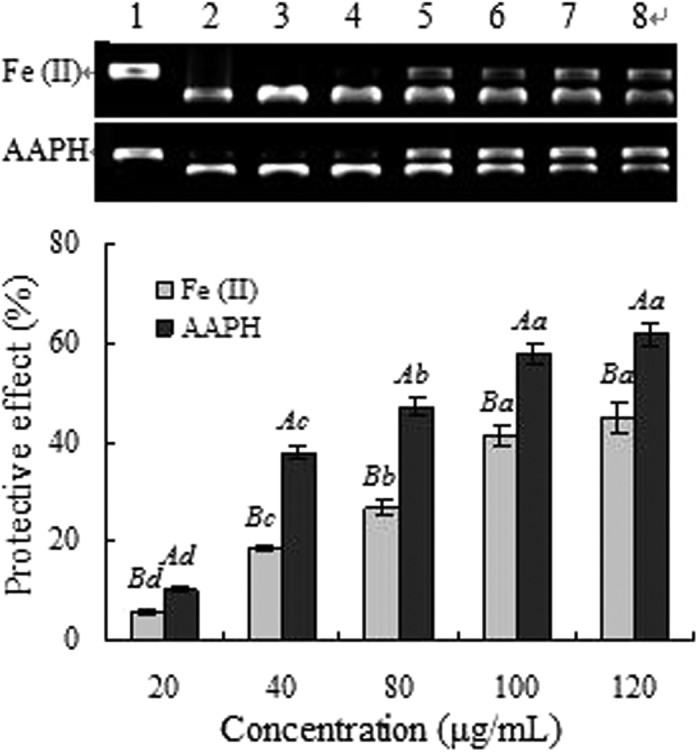
Protection effects of the essential oil from C. rotundus rhizomes on DNA oxidative damage induced by Fe2+ and AAPH.Lane 1, the native DNA; lane 2, the DNA treated with Fe2+/AAPH; lane3, the DNA treated with Fe2+/AAPH and solvent; lane 4–9, the DNA treated with the essential oil. Different lowercase letters indicate statistically significant differences between the means (p < 0.05) for essential oil of different concentration. Different capital letters indicate statistically significant differences between the means of DNA oxidative damage induced by Fe2+ and AAPH (p < 0.05) for essential oil at the same concentration.